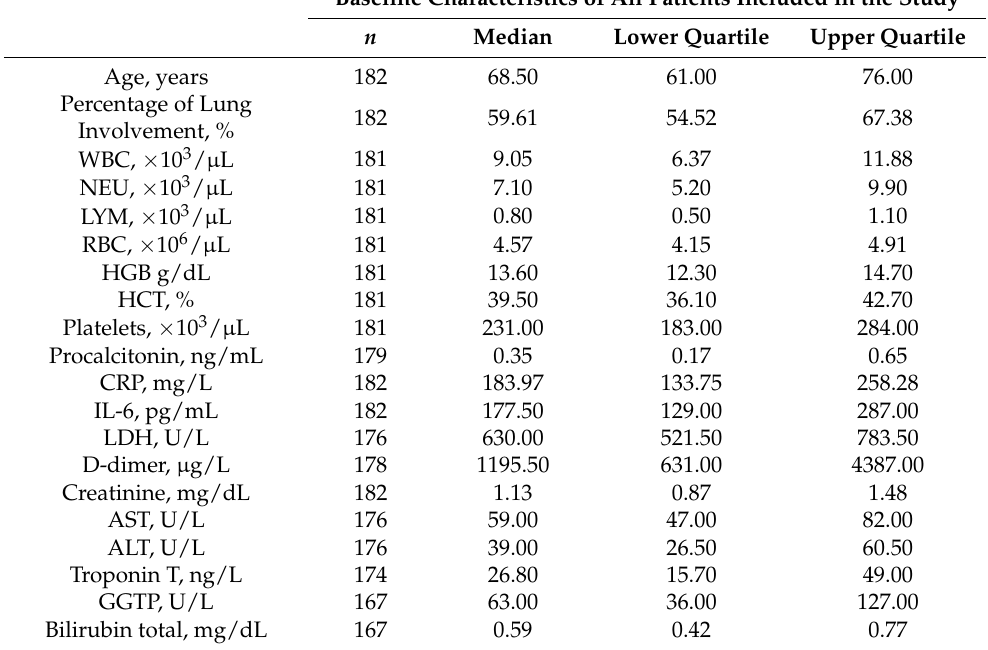
Table 1. Baseline characteristics of all patients included in the study.